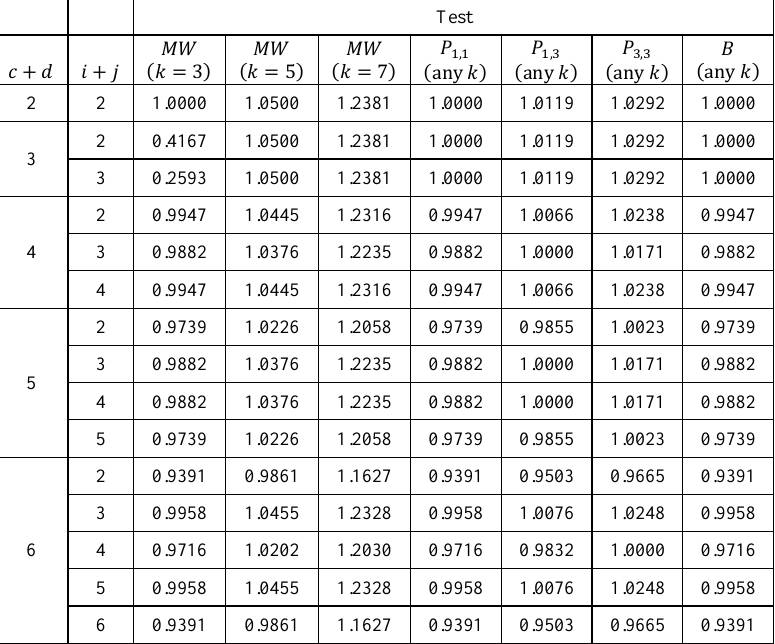
Table 4. AREs of 𝑇 for Logistic distribution w.r.t. different tests 𝑐,𝑑;𝑖,𝑗